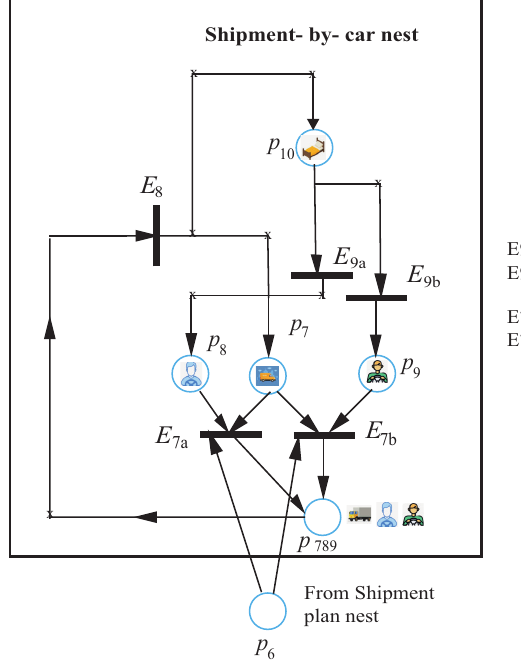
Figure 9. Hierarchical modeling of the courier example: